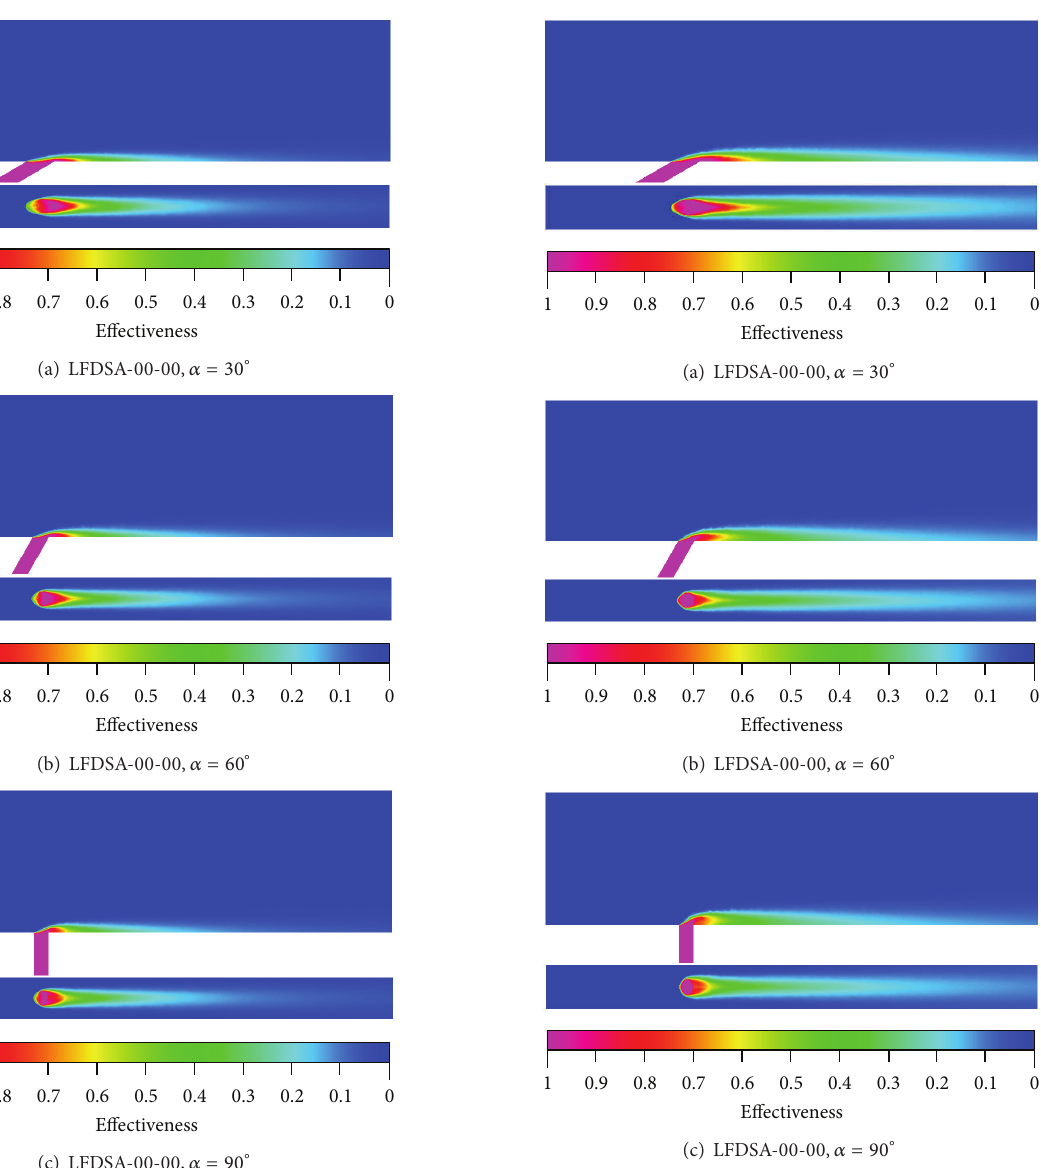
Figure 24: Top and symmetric planes effectiveness of LFDSA-00-00 for different streamwise angles and 𝑀 = 0.2 .